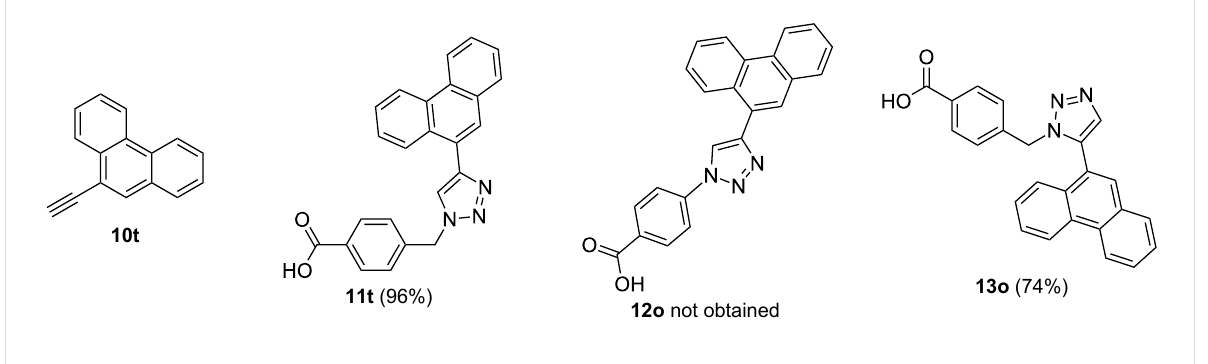
Table 2: Copper-catalyzed [2 + 3] cycloadditions of resin bound azide 7 with five terminal alkynes. Compounds 13 , with the exception of 13f , were only characterized during compound library synthesis, by HPLC–MS analysis. (continued)